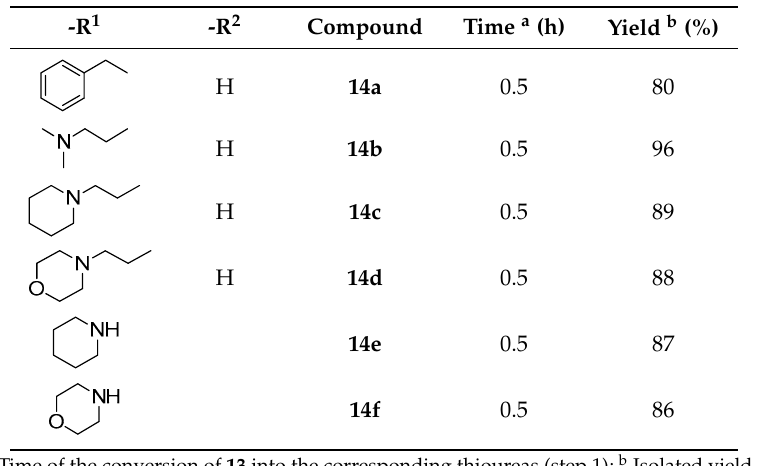
Table 5. Chemical structures and yields obtained via the sequential MCR synthesis of 14a – 14f .